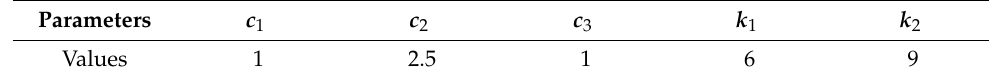
Table 3. Parameters for the SMC controller design.